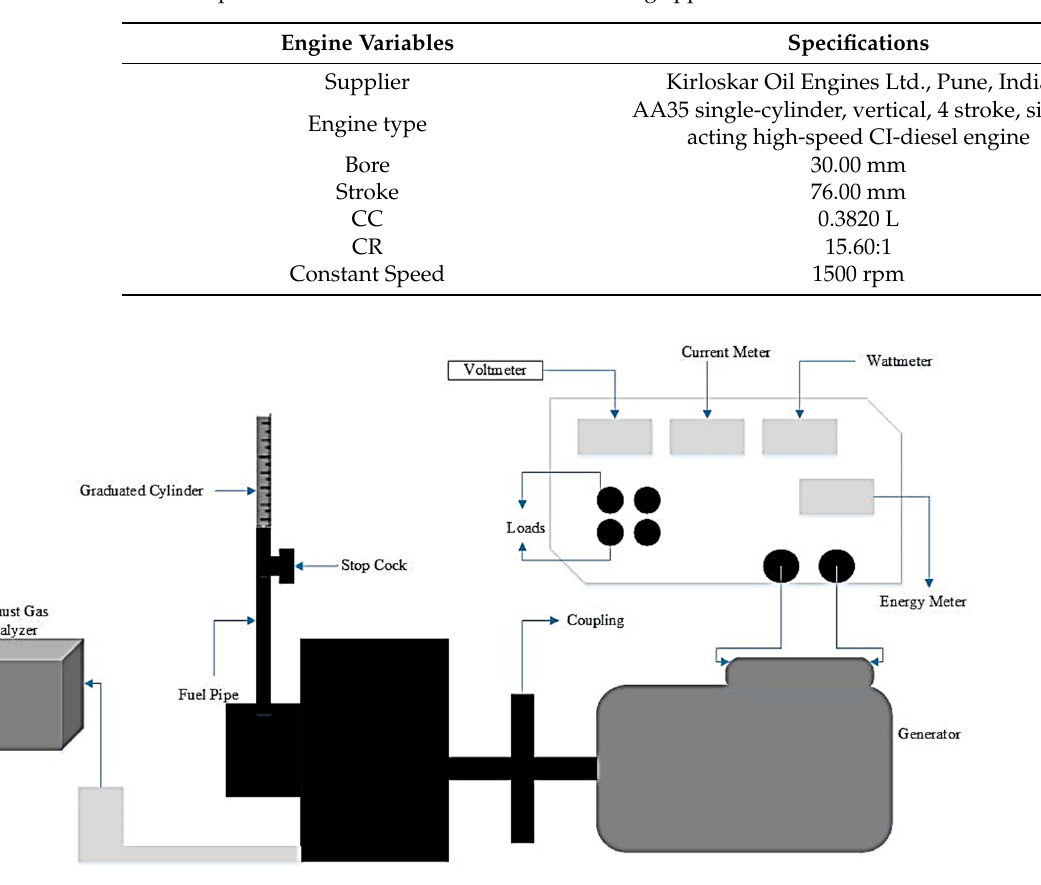
Table 3. Specific technical characteristics of the testing apparatus.